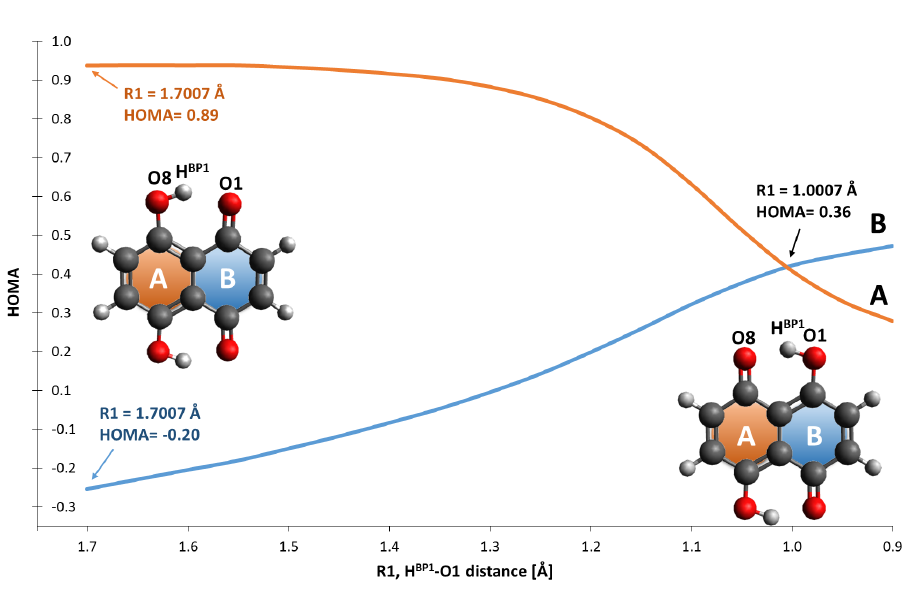
Figure 4. HOMA index evolution as a function of the intramolecular hydrogen bond distance changes.